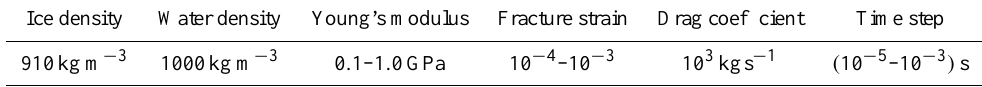
Table A1. Typical parameters used in the